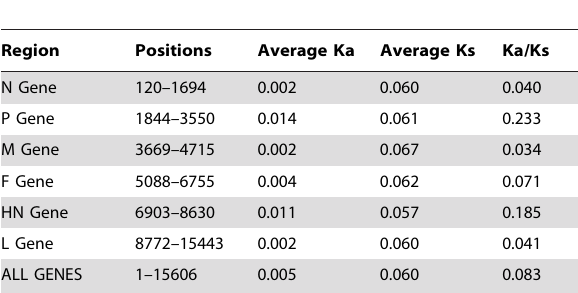
Table 6. Nonsynonymous (Ka) vs. Synonymous Mutations in the Coding Region of HPIV-1